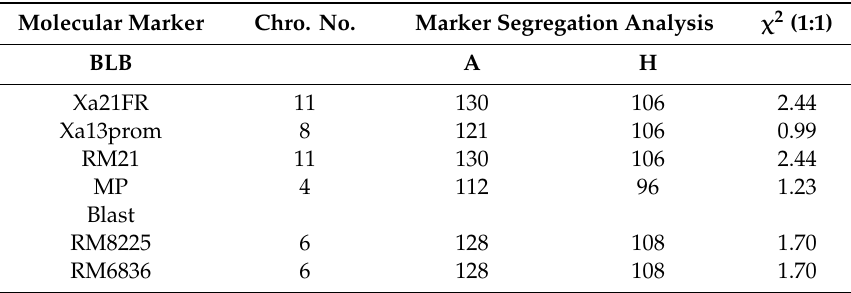
Table 2. Foreground marker segregation analysis of the BC 2 F 1 progenies. Molecular Marker